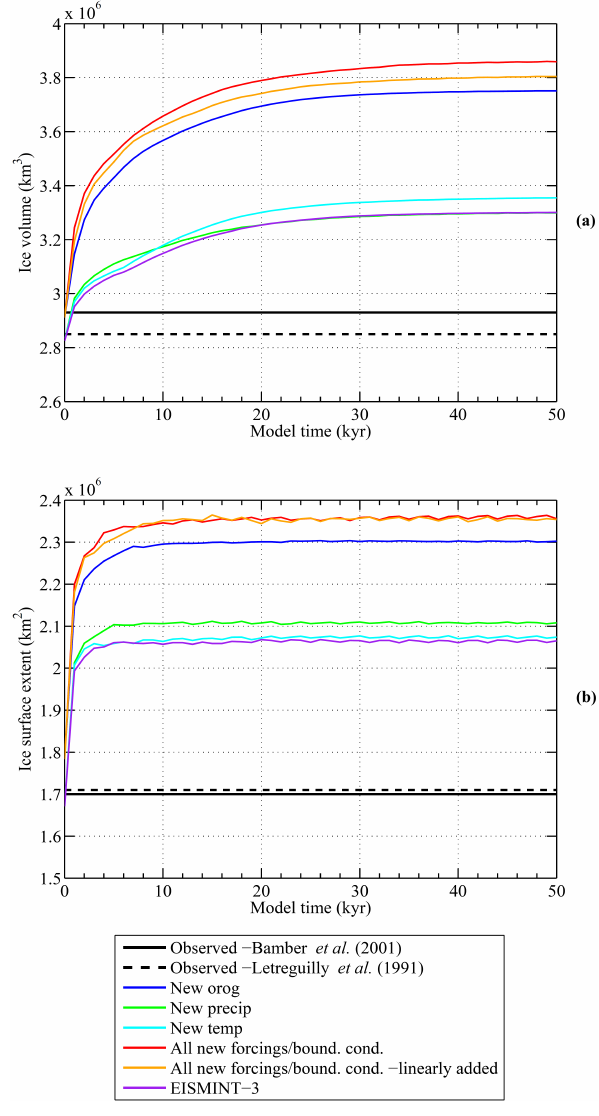
Fig. 1. Evolution of the modelled ice-sheet (a) volume and (b) sur- face extent for each of the different boundary conditions and forc- ings changed one at a time relative to EISMINT-3, when they are all varied together and when they are linearly combined. The EISMINT-3 experiment and observations derived from Bamber et al. (2001) and Letreguilly et al. (1991) are also shown for compari-